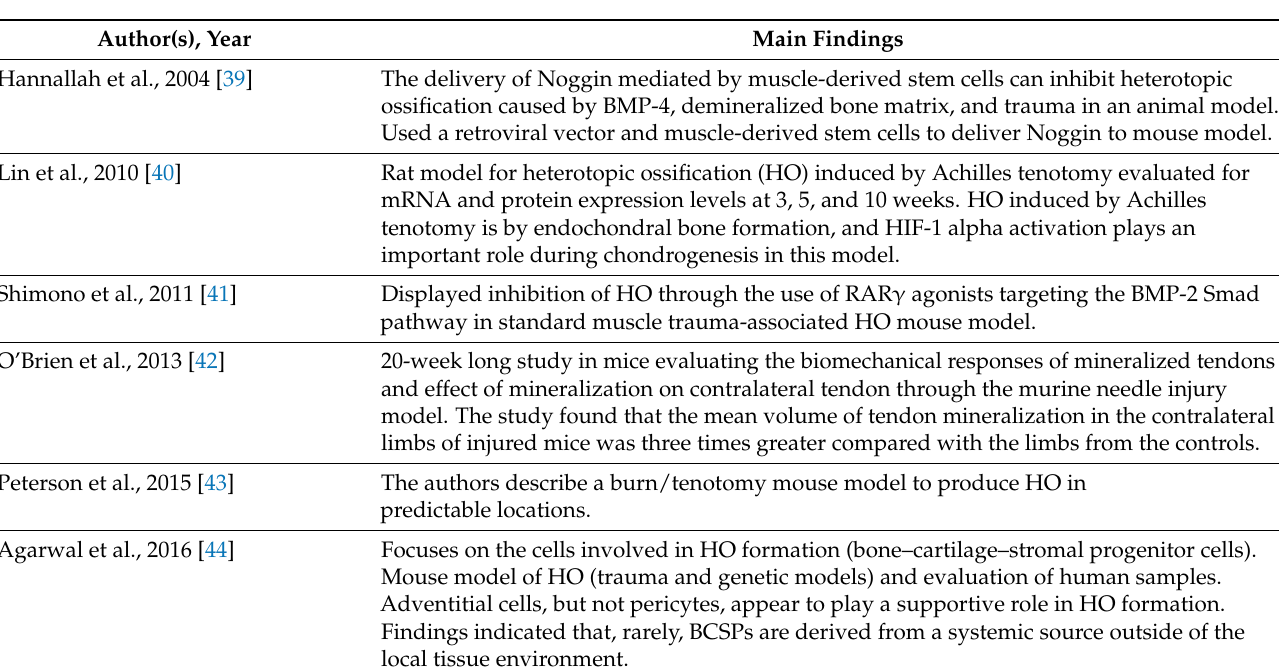
Table 5. Relevant articles (Molecular Studies; 2004–2019) and their main